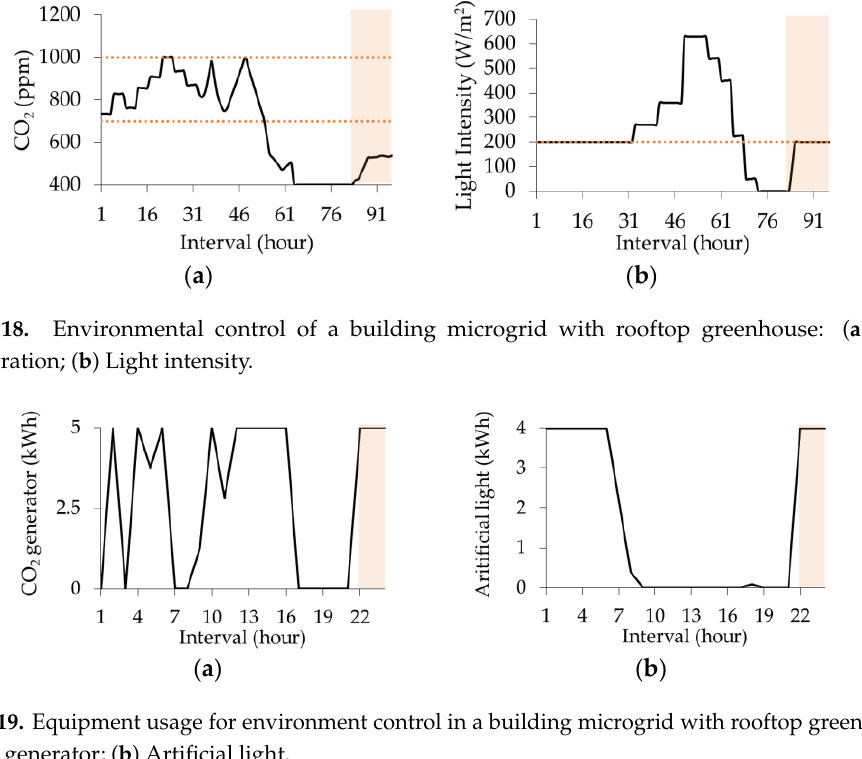
Figure 19. Equipment usage for environment control in a building microgrid with rooftop greenhouse: ( a ) CO 2 generator; ( b ) Artificial light.